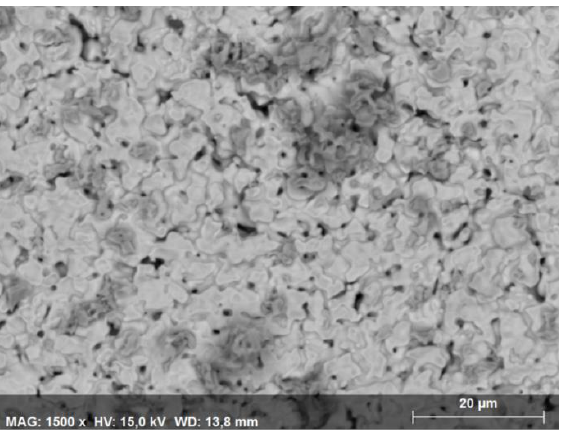
Figure 4. BSE-SEM micrograph of the cathode–electrolyte interface after selective dissolution of